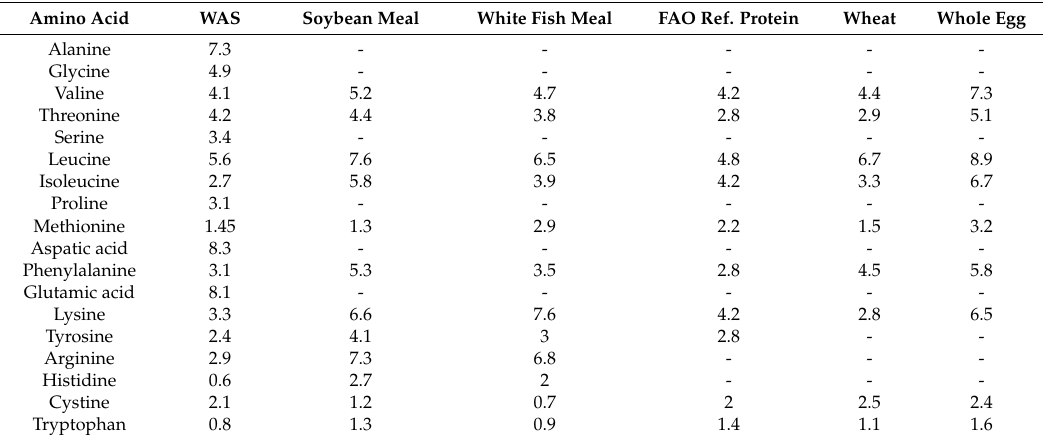
Table 1. Comparison of amino acid distribution in WAS with the content in single cell proteins and conventional feed meals (adapted from